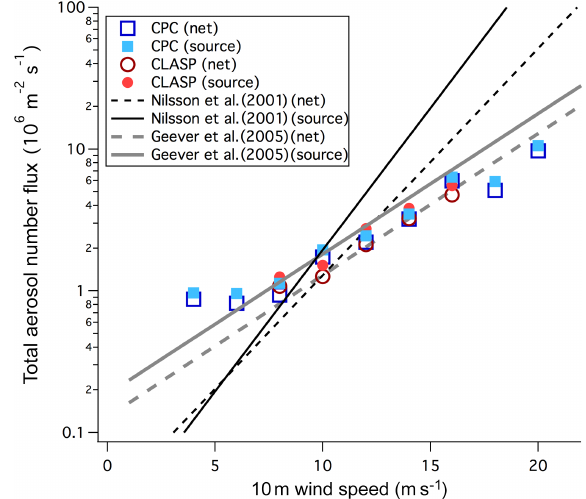
Figure 4. Hourly total aerosol number source fluxes from the CPC and CLASP vs. wind speed (data from 2015). Error bars correspond to standard deviations within the bins. Also shown are source flux relationships derived by Geever et al. (2005; > 5nm radius) from the coastal site of Mace Head and Nilsson et al. (2001; > 5 radius nm) from the open ocean of the Arctic.